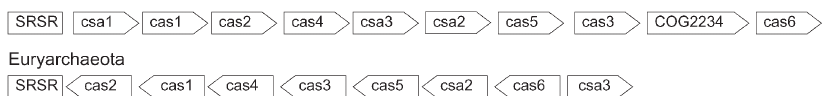
Figure 3. Typical composition and orien- tation of the major gene components of superoperons which are closely linked to repeat clusters in crenarchaea and eury- archaea. The cas genes and their COG identities are given in Tables 4 and 5.